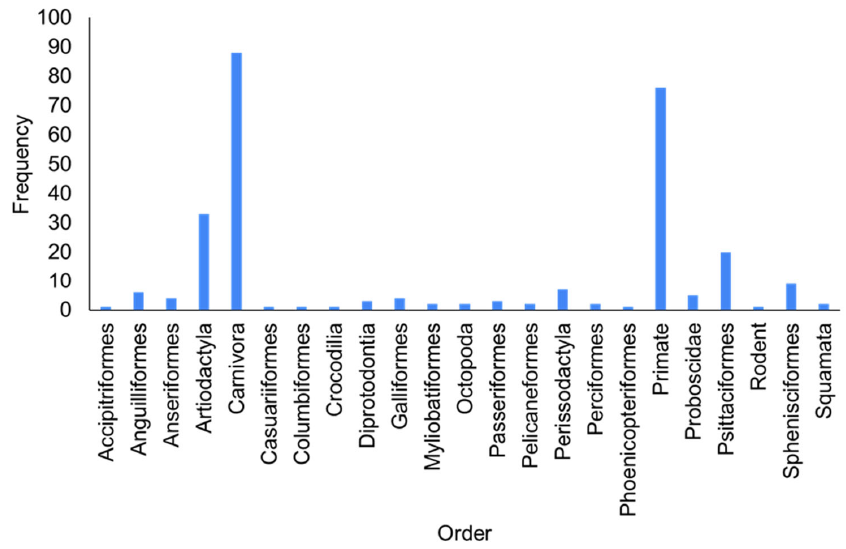
Figure 2. Overview of the frequency of orders highlighted in news reports. Positive or negative behavioral responses to the closures were reported in 224